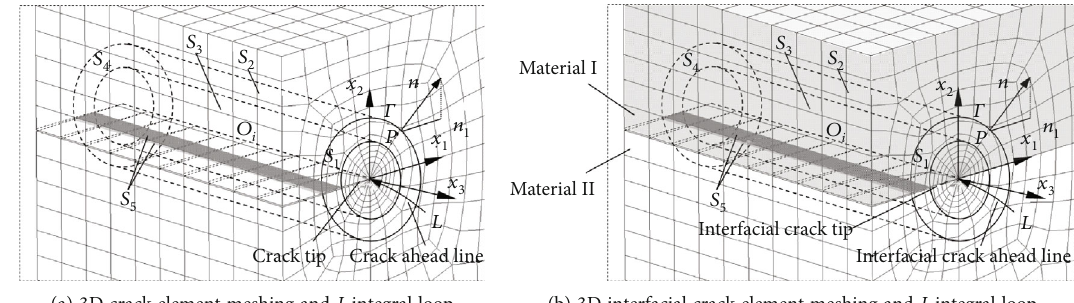
Figure 2: The crack fi nite element meshing and 3D J -integral loop